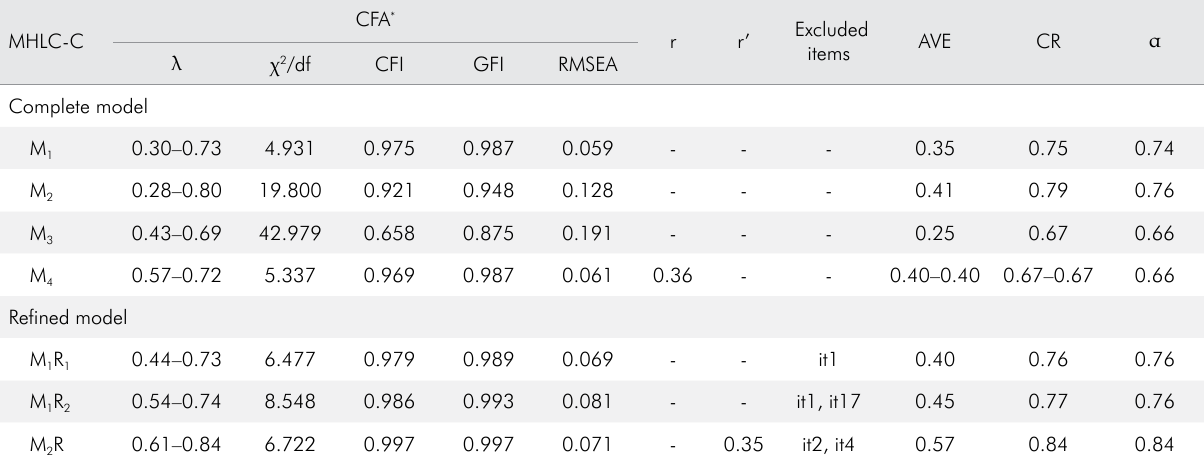
Table 5. Confirmatory factorial analysis (CFA), average variance extracted (AVE), and reliability (CR, α ) of the models in the Multidimensional Health Locus of Control - Form C (MHLC-C) items fit to the sample. MHLC-C